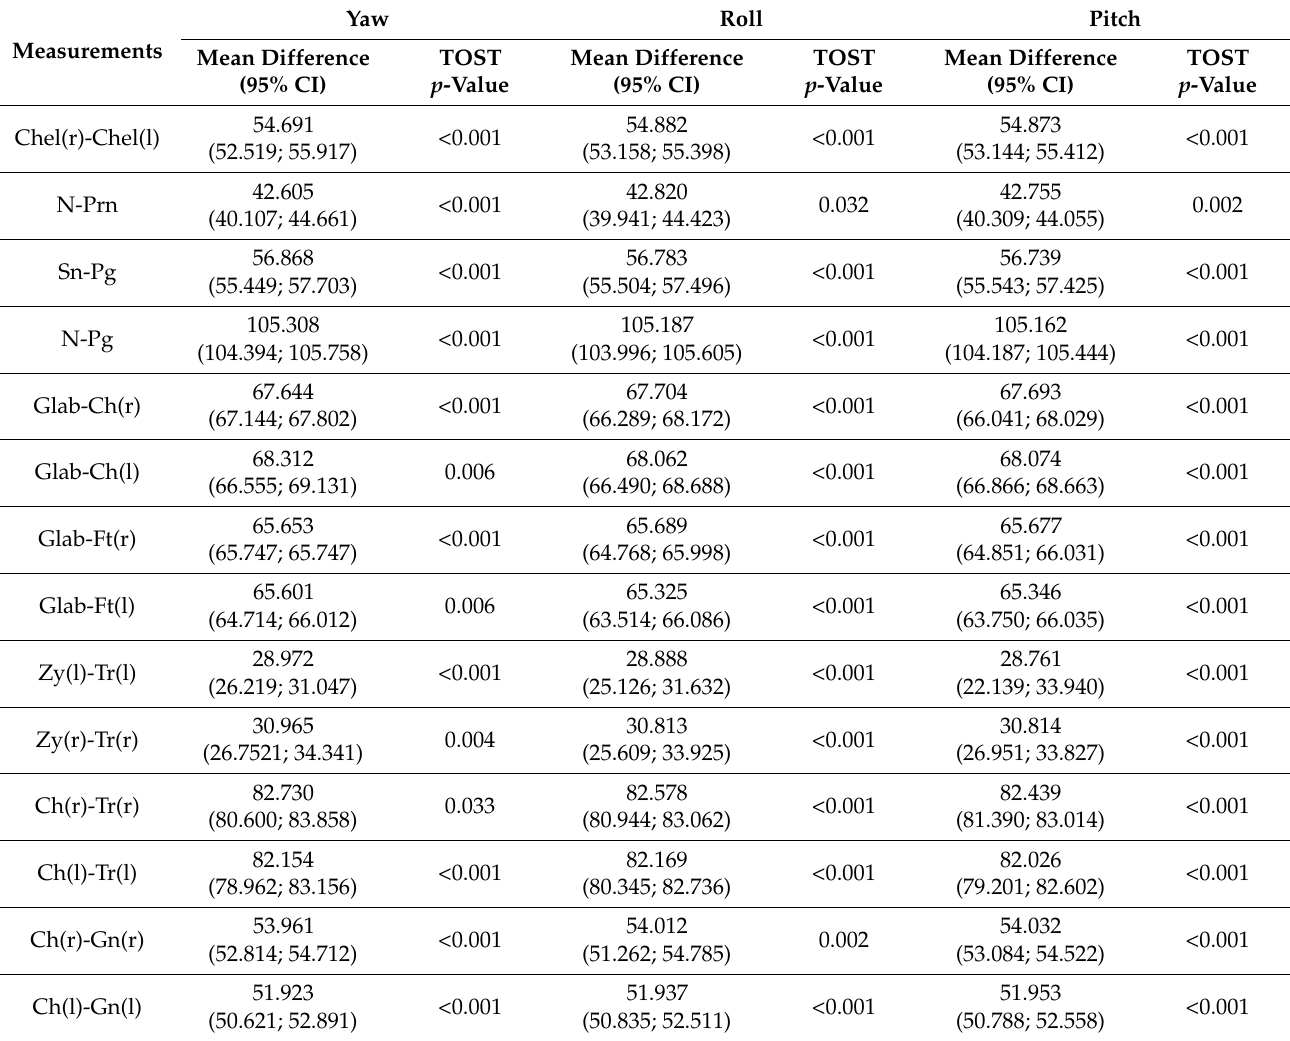
Table 3. Mean differences with 95% confidence intervals between linear measurements performed on 3D images taken in the reference position with those obtained on acquisitions with yaw, roll, and pitch angulations. When the TOST p -value was less than 5% ( p < 0.05) we rejected the null hypothesis of nonequivalence and concluded that the measurements were